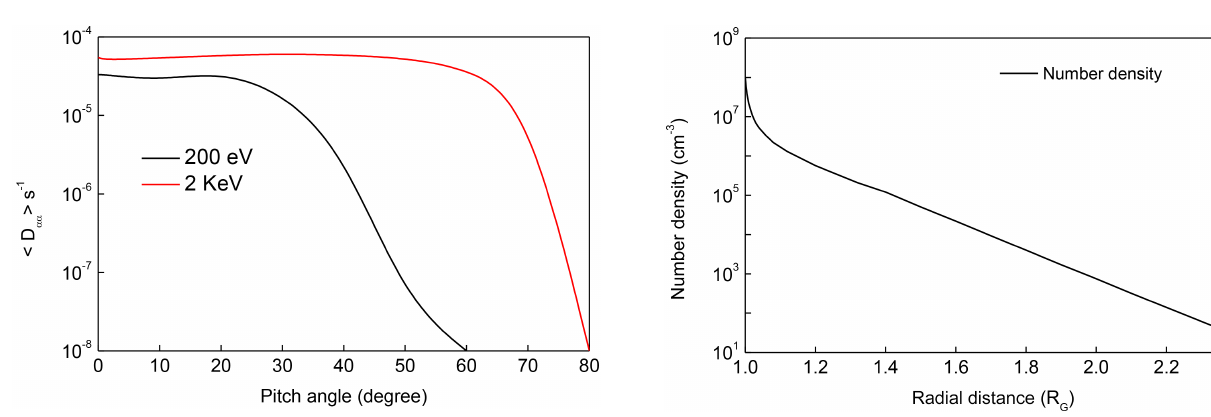
Figure 3. Variation in O 2 number